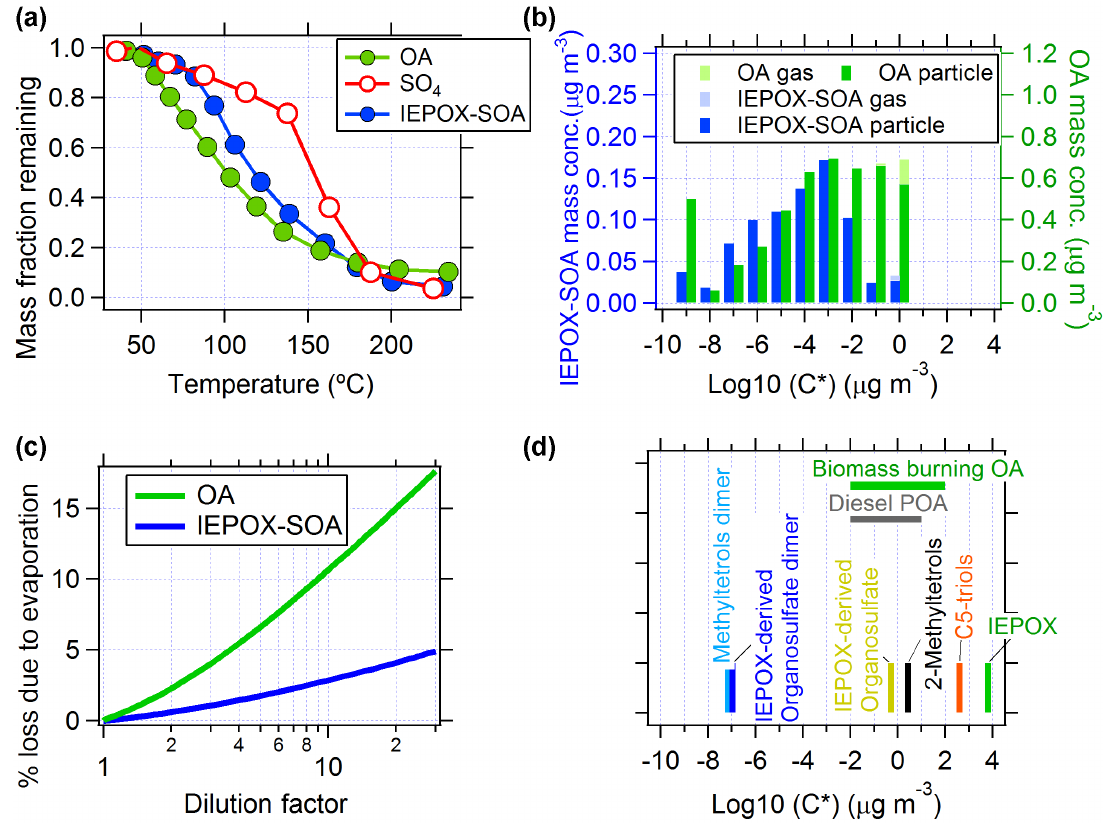
Figure 1. (a) Mean mass fraction remaining of IEPOX-SOA, OA, and SO 4 vs. temperature in TD “thermograms” during the SE US study. (b) Volatility distributions of IEPOX-SOA and OA estimated from TD thermograms (see text). Bars are offset for clarity and were both calculated for integer log( C ∗ ) values. (c) Evaporation losses of IEPOX-SOA and OA as a function of dilution factors. (d) Volatility of typical IEPOX-SOA molecular species in the aerosol phase based on the SIMPOL group contribution method (Pankow and Asher, 2008). The reduction in vapor pressure upon addition of a nitrate group was used to estimate the effect of the sulfate group, due to lack of SIMPOL parameters for the latter, and the derived C ∗ may be overestimated for this